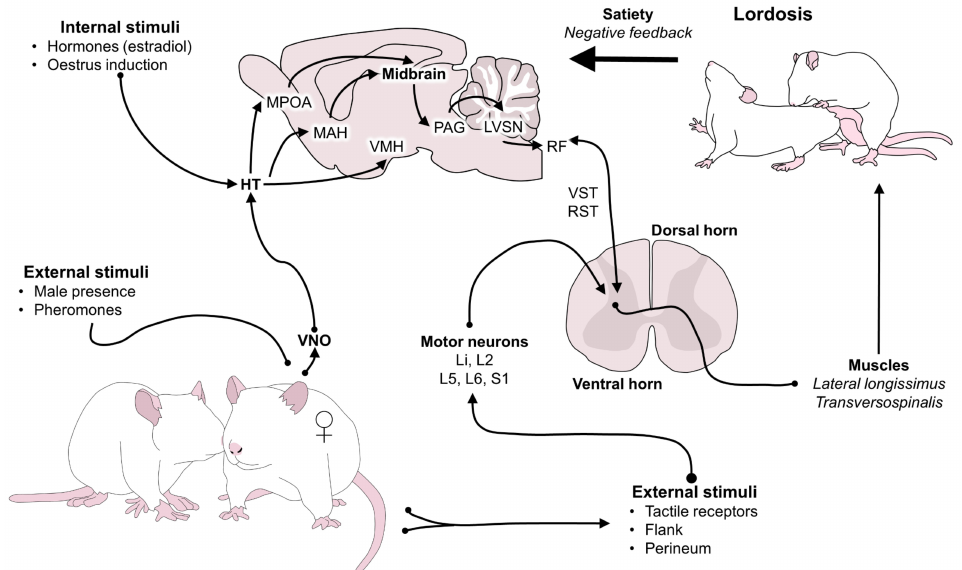
Figure 6. The mechanisms of motivation and satiety are complementary and mediate the appetitive- ness or aversivity of stimuli. For example, a female rat may perceive a male as a positive